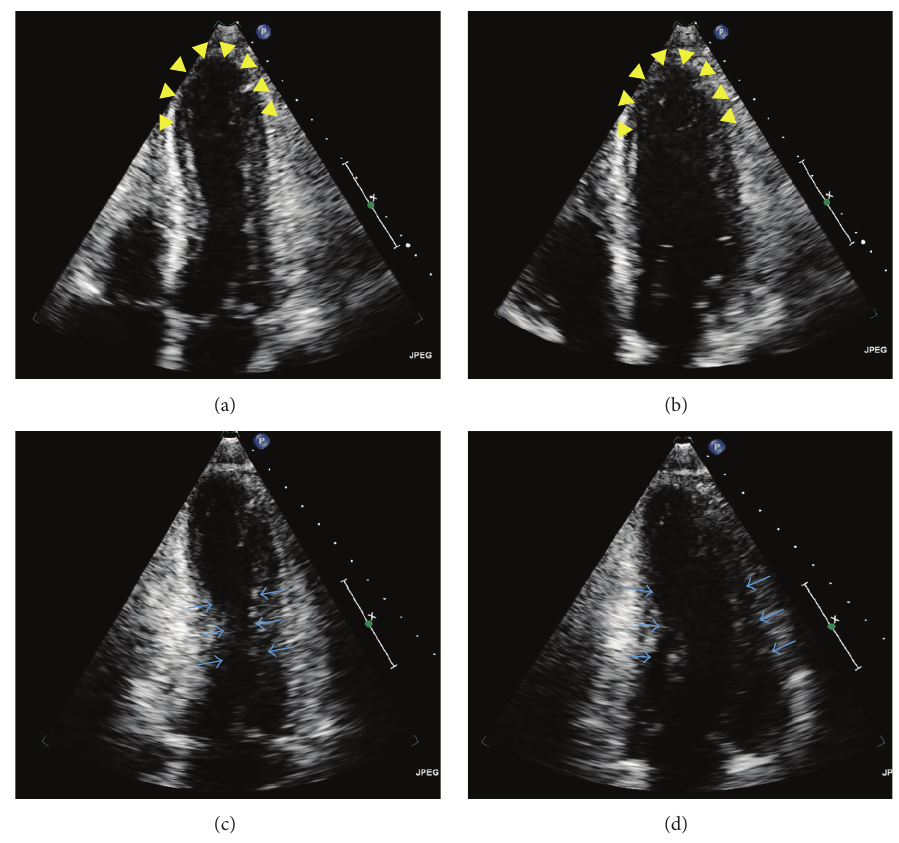
Figure 1: Initial transthoracic echocardiogram in the acute setting revealing features suggestive of stress cardiomyopathy. Systolic (a) and diastolic (b) apical 4-chamber views reveal akinetic apical and mid-anteroseptal segments (arrowheads) with hyperdynamic middle segments. Systolic (c) and diastolic (d) apical 2-chamber views disclose normal wall motion of the mid-cavity (arrows). The circumferential pattern of left ventricular myocardial dysfunction characterized by symmetric wall motion abnormalities involving the septal, anterior, and lateral walls is highly suggestive of stress